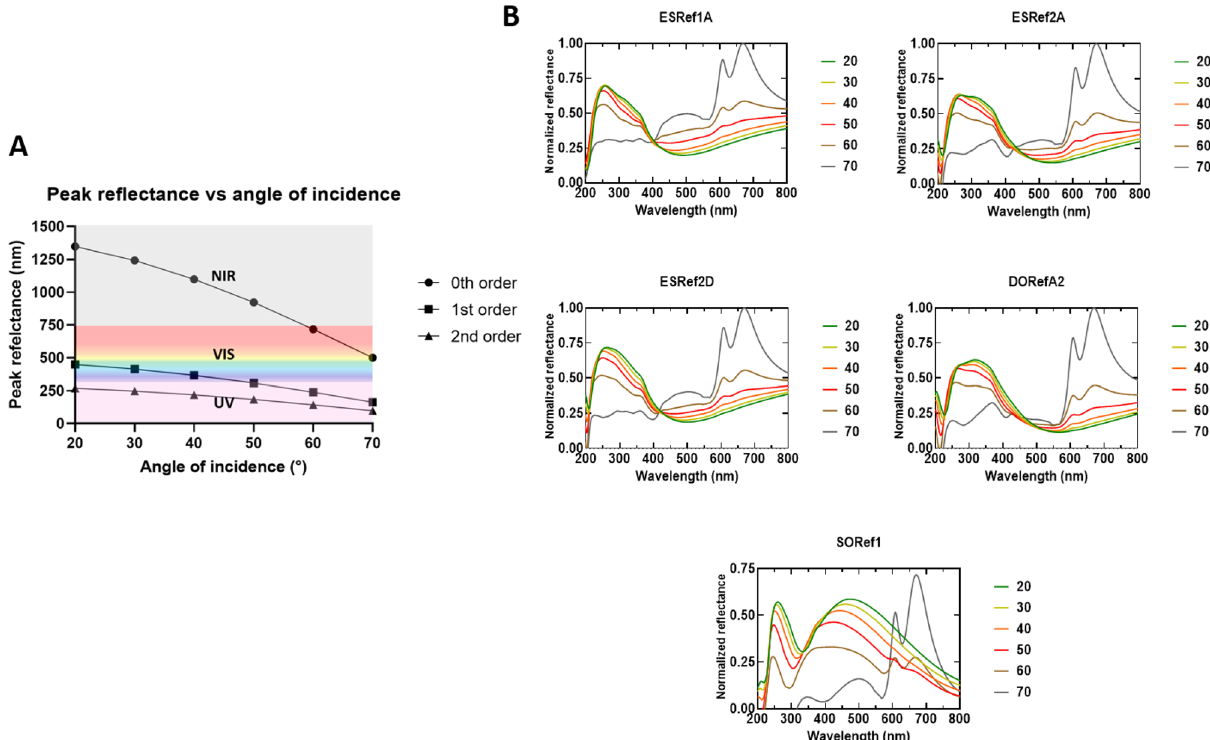
Figure 5. ( A ) Calculated peak reflectance of 0th, 1st, and 2nd order of reflection vs angle of incidence as calculated using Eq. (1). ( B ) UV–VIS reflectance spectra (200–800 nm) of single-layer films fabricated by spin coating 1% w/w reflectin in HFIP onto clean Si wafers. The angle of incidence was varied between 20° and 70° (10°